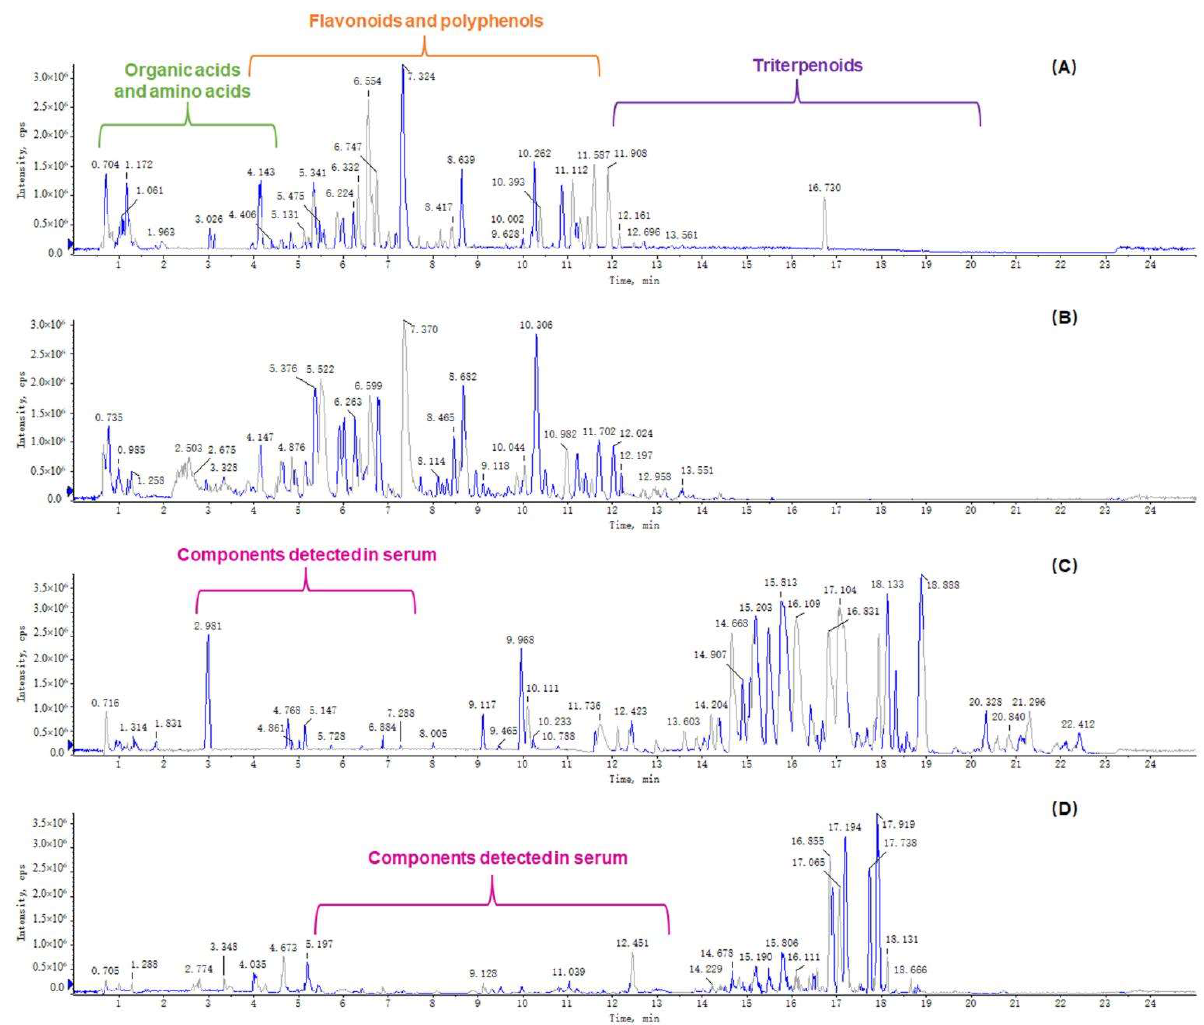
Figure 6. Base peak chromatograms. ( A ) WESJ in positive ion mode; ( B ) WESJ in negative ion mode; ( C ) serum sample collected at 2.0 h after dosing in positive ion mode; ( D ) serum sample collected at 2.0 h after dosing in negative ion mode.